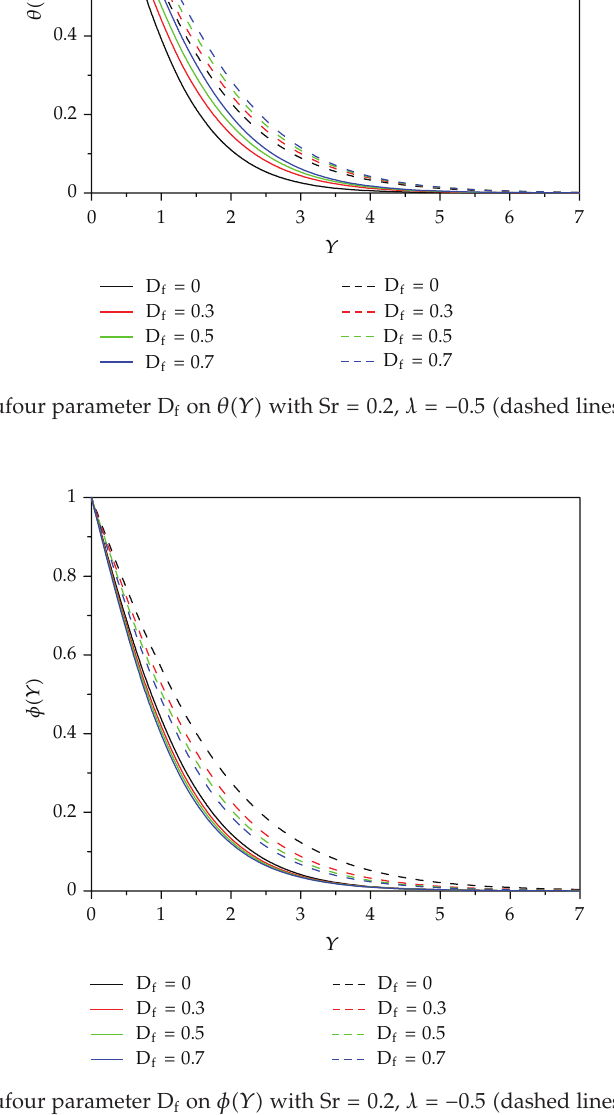
Figure 4: E ff ect of Dufour parameter D f on φ (cid:3) Y (cid:4) with Sr (cid:10) 0 . 2, λ (cid:10) − 0 . 5 (cid:3) dashed lines (cid:4) , and λ (cid:10) 0 . 5 (cid:3) solid lines (cid:4)